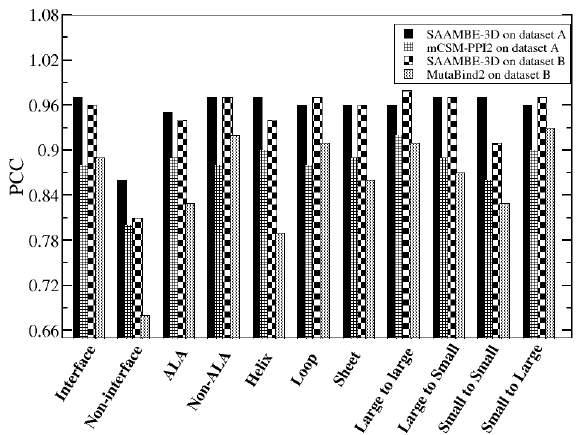
Figure 4. Performance of SAAMBE-3D, mCSM-PPI2 and MutaBind2 on different classes of mutations.